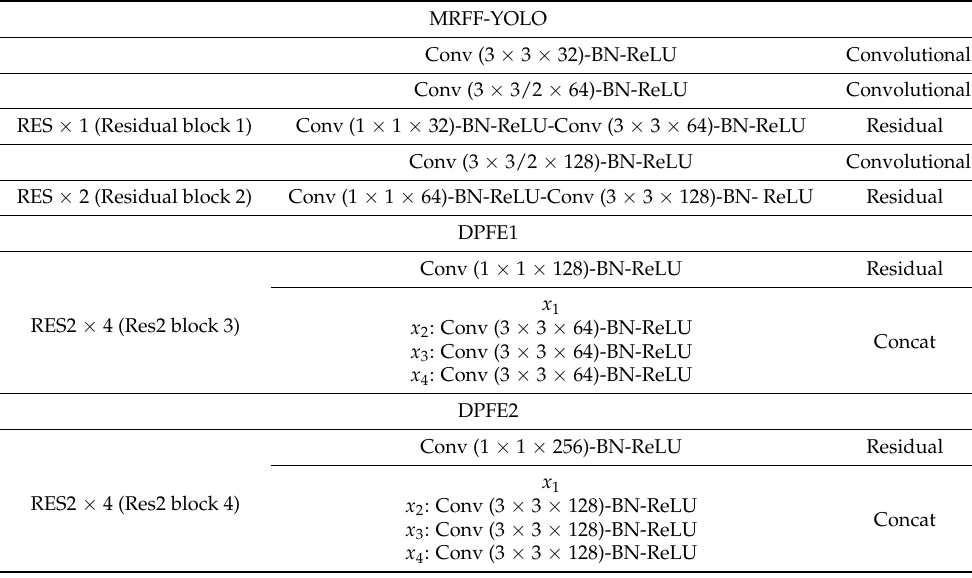
Table 4. The feature extraction network’s parameters of FE-YOLO.